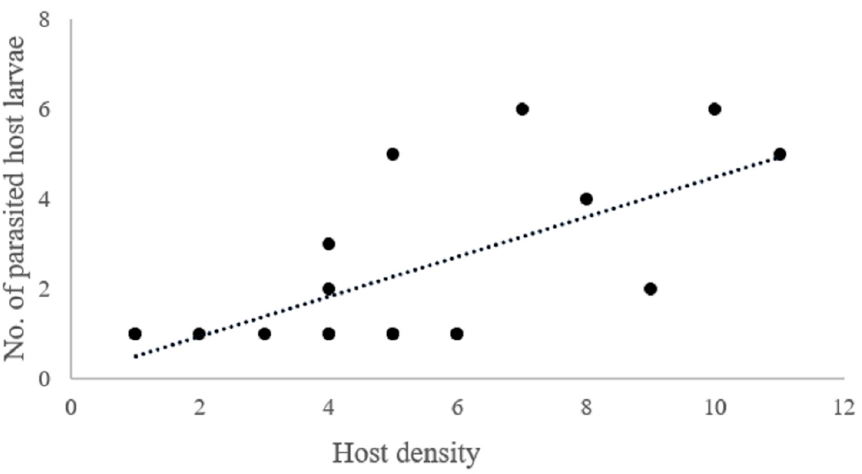
Figure 4. Relationship between host density (=number of host larvae per sentinel log) and number of